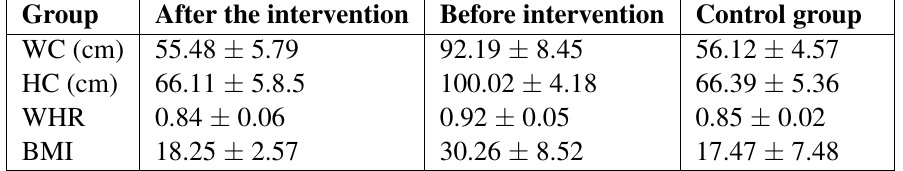
Table 2 Comparison of general clinical data of obese children after aerobic exercise